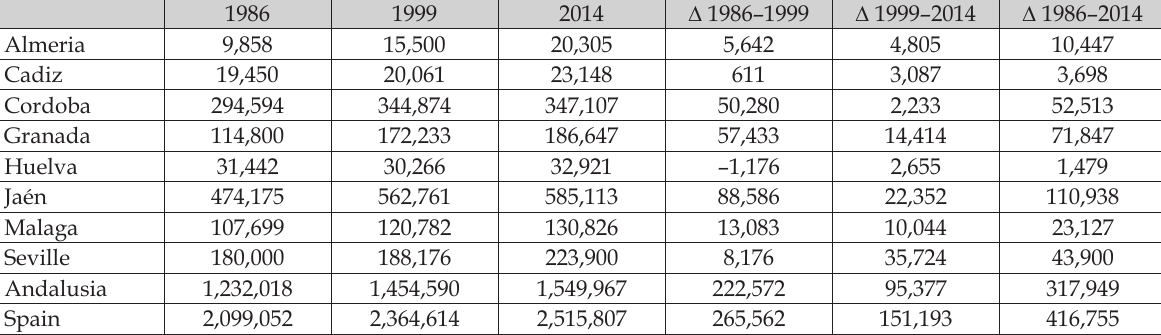
Table 3. Evolution in the surface area planted with olive groves (ha) in Andalusia by provinces, 1986–2014.